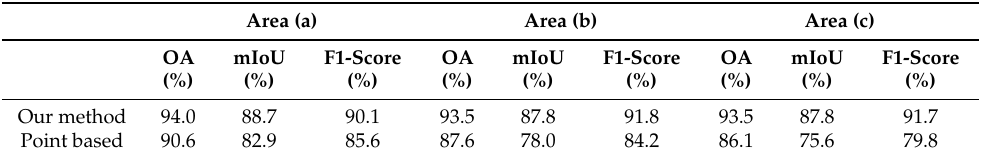
Figure 11. Misclassification cases in the Shenzhen dataset. ( a ) Faults due to edge interruption. ( b ) Faults due to untrained object shapes. Table 4. Quantitative evaluation of the supervoxel-based results and point-based results of the proposed method on the Shenzhen airborne LiDAR